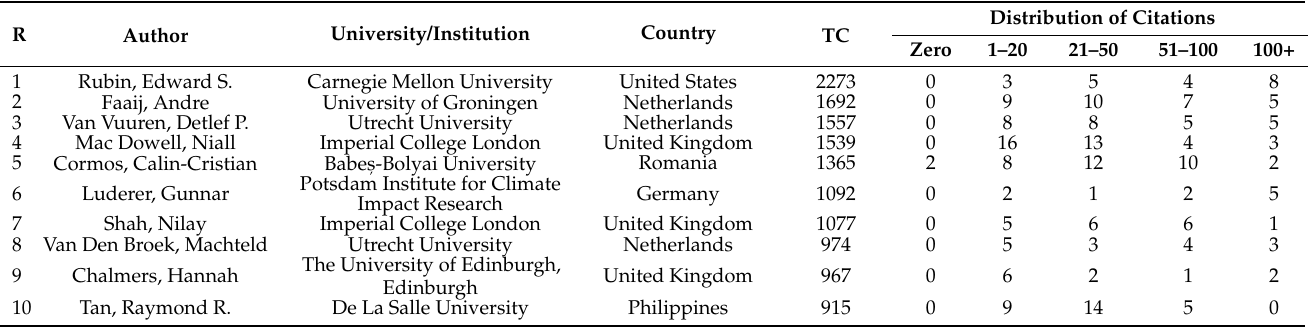
Table 2. Top ten most productive authors based on total